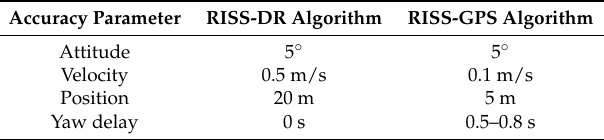
Table 2. Navigation system experimental data